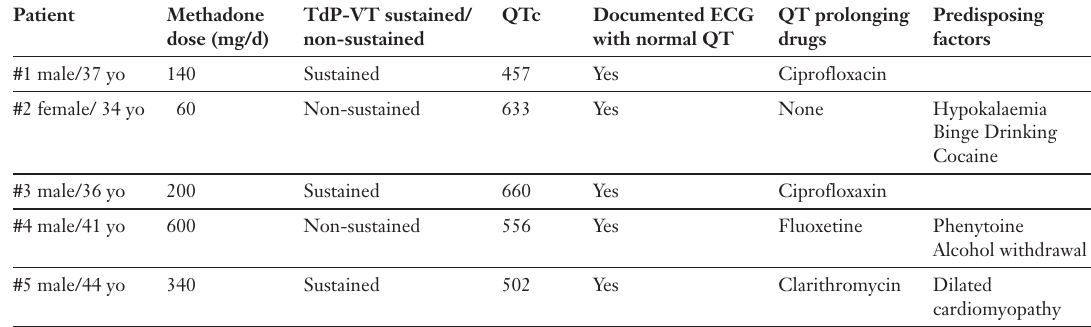
Circumstances under which TdP-VT occurred in five patients in the methadone mainte- nance